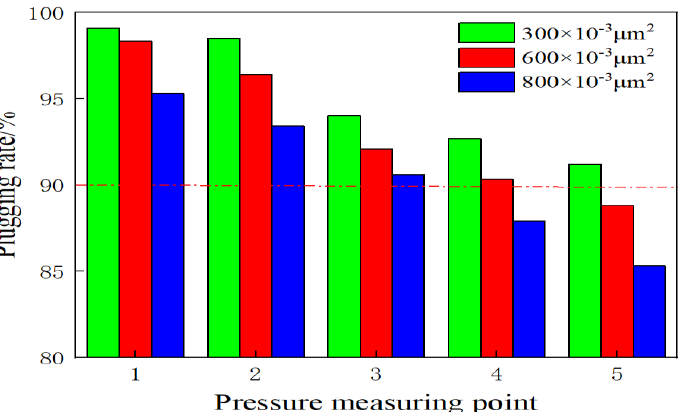
Figure 15. Change in the plugging rate at each measuring point of the sand-filled pipe exhibiting varying permeability characteristics.